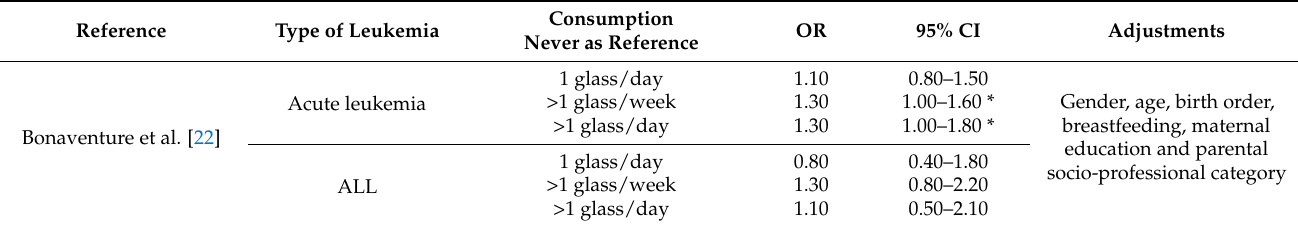
Table 8. Overview of the association between maternal soft drink consumption during pregnancy and risk of acute leukemia in